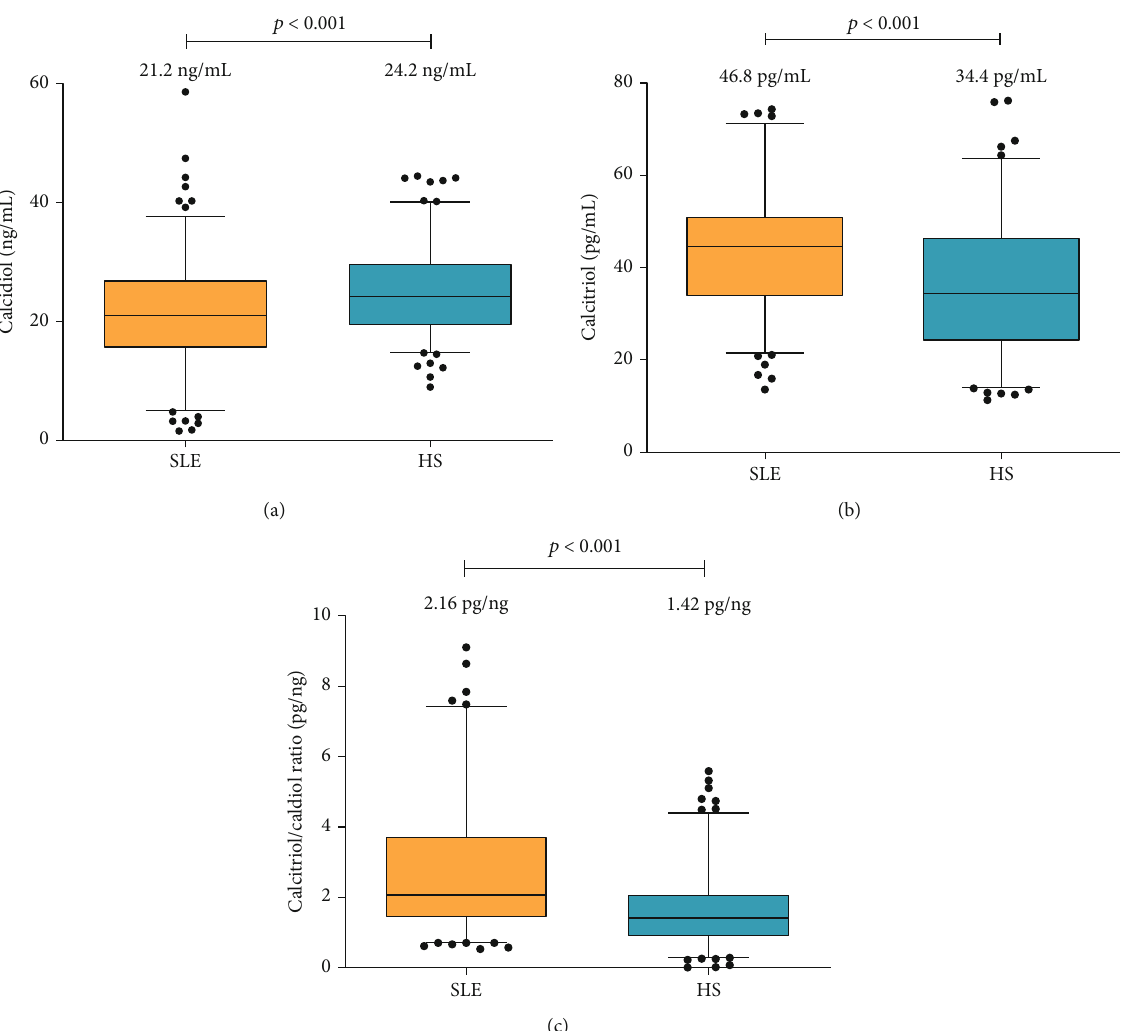
Figure 1: Vitamin D serum metabolites and vitamin D hydroxylation e ffi ciency ratio from SLE patients vs. HS. (a) Calcidiol serum levels of SLE patients (5.1 – 40.4ng/mL) vs. HS (14.8 – 40.2ng/mL); (b) calcitriol serum levels of SLE patients (22.1 – 103pg/mL) vs. HS (8.92 – 89.8pg/ mL); (c) e ffi ciency of vitamin D hydroxylation by the calcitriol/calcidiol ratio of SLE patients (0.73 – 10.5pg/ng) vs. HS (0.30 – 4.31pg/ng). Data provided in median ( p 5 th – p 95 th in parenthesis); Mann – Whitney U test. SLE: systemic lupus erythematosus; HS: healthy